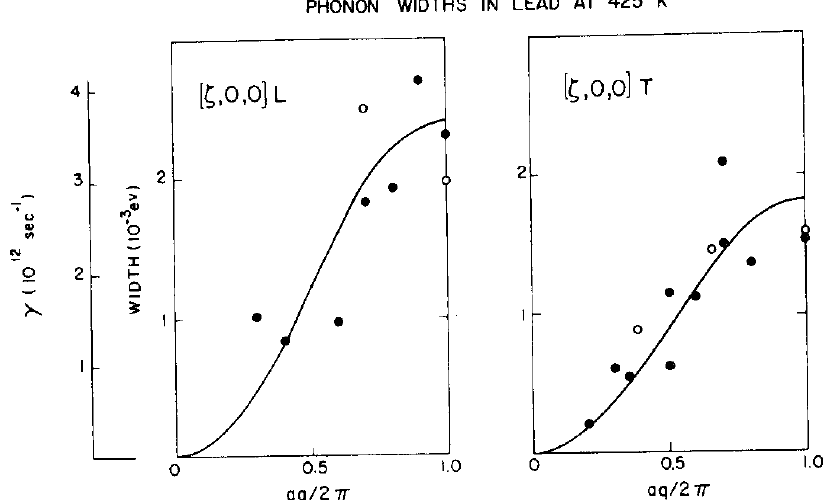
Figure 21. The full-width at half-maximum of the neutron groups in lead corrected for resolution as a function of the wavevector for the [ ζ ,0,0] T and L branches at 425 °K. The widths reveal a marked broadening of the phonons at high temperatures. The solid lines show the best fits to expressions of the form of Equation (28) with n = N = 1. The scatter gives a measure of the accuracy. This figure is taken from Figure 7 of ref. [59] by courtesy of the